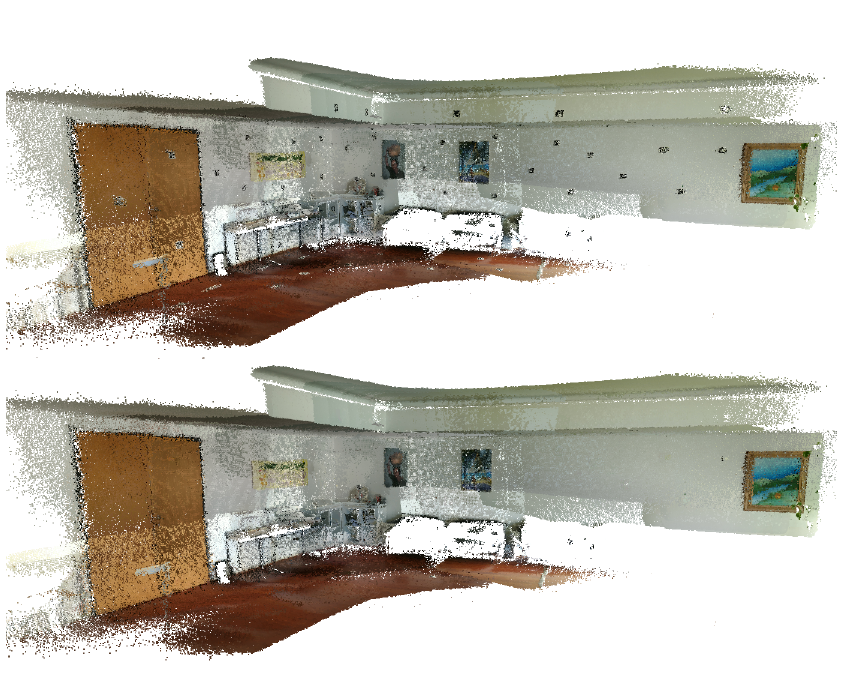
Figure 24. MeetingRoom dataset coloured with texture: ( top ) obtained from original images; ( bottom ) obtained from restored